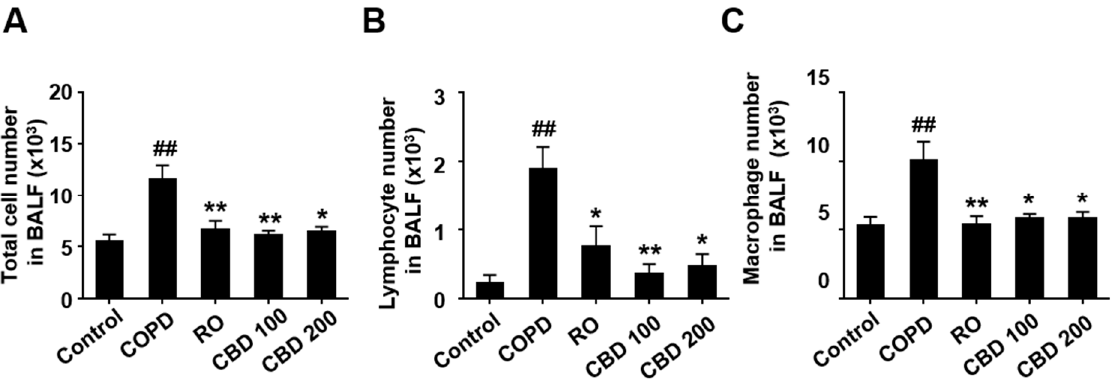
Figure 2. Effects of CBD on inflammatory cell recruitment to COPD-induced mice BALF. ( A ) Number of total cells. ( B ) Number of lymphocytes. ( C ) Number of macrophages. Control: mice instilled intratracheally with normal saline; COPD: mice exposed to CS and LPS; RO: mice exposed to 10 mg/kg roflumilast plus CS and LPS; CBD 100: mice exposed to 100 mg/kg CBD plus CS and LPS; CBD 200: mice exposed to 200 mg/kg CBD plus CS and LPS. Results are presented as means ± SEMs. ## p < 0.01 compared with the control group; * p < 0.05, ** p < 0.01 compared with the COPD group.